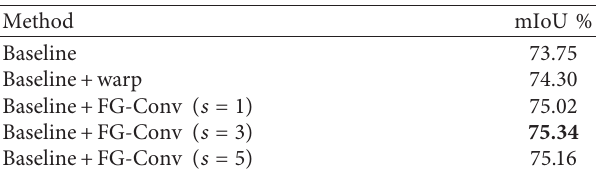
Table 3: Ablation study of the prediction consistency loss on the Cityscapes validation set.